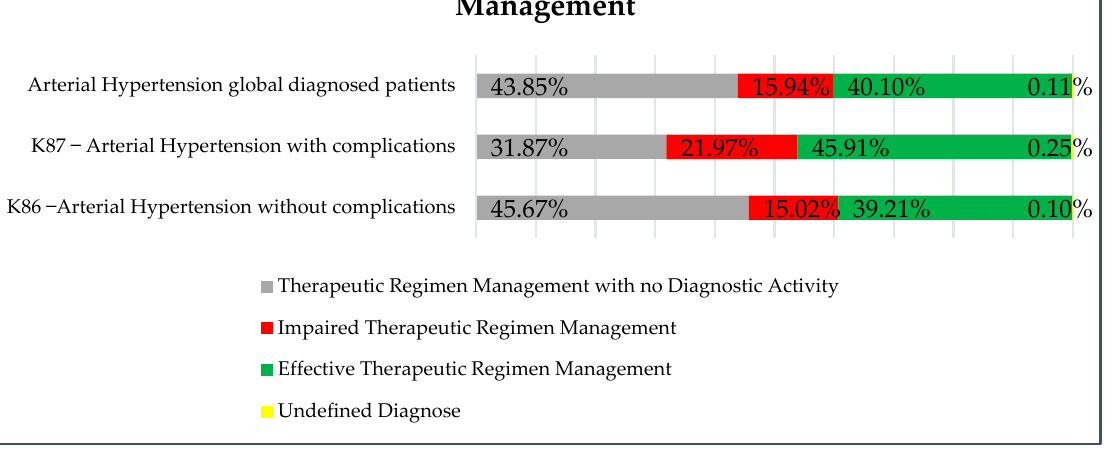
Table 1. Distribution and prevalence of medical diagnoses in hypertension patients.